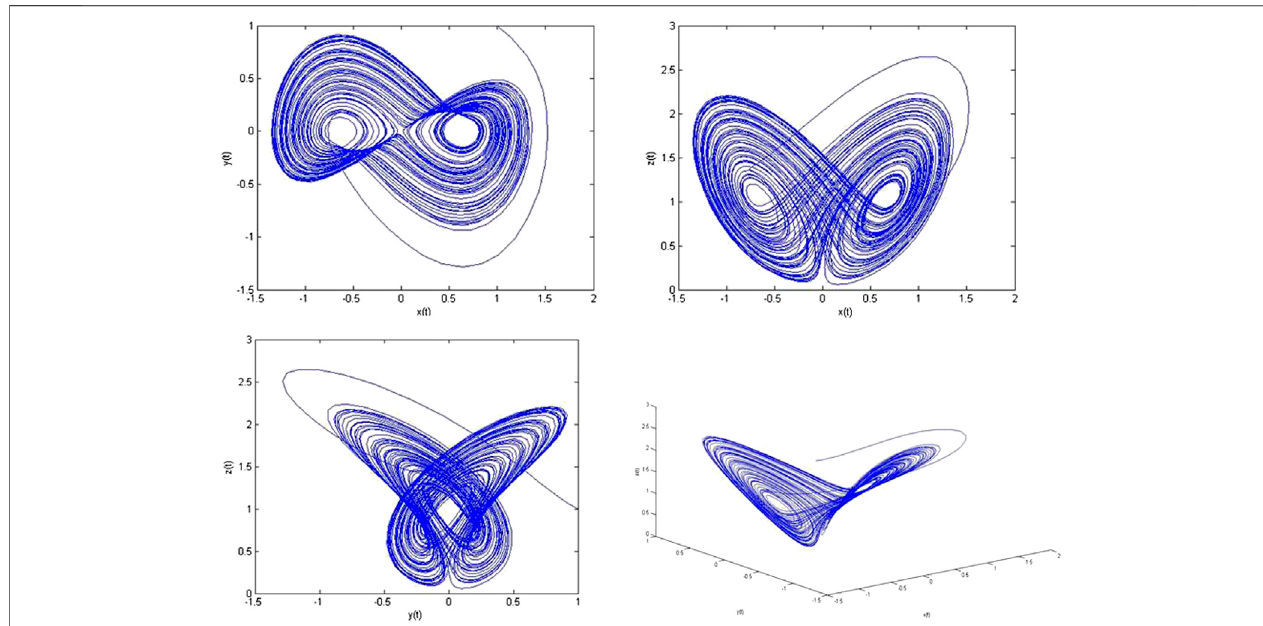
FIGURE 1 | Phase portraits of system Eq. 1.1